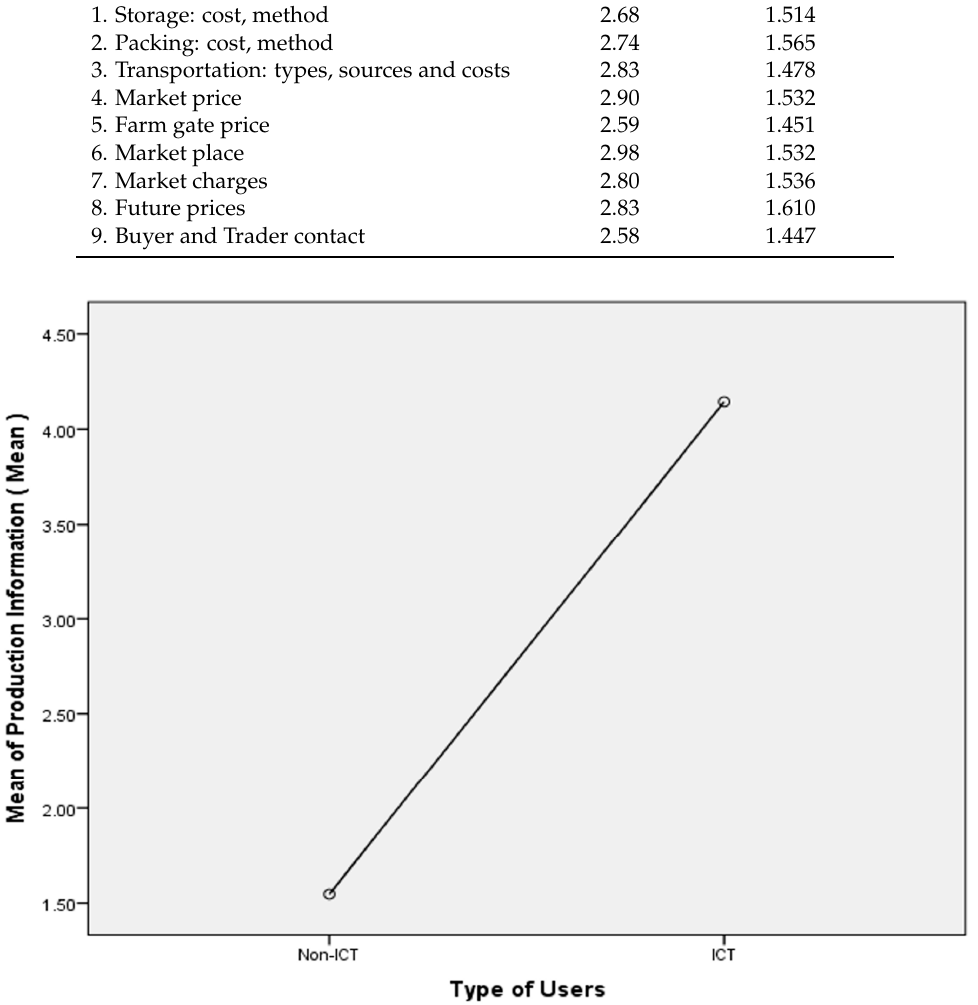
Figure A1. Estimated marginal means of level of access of production information (mean) vs. type of users.